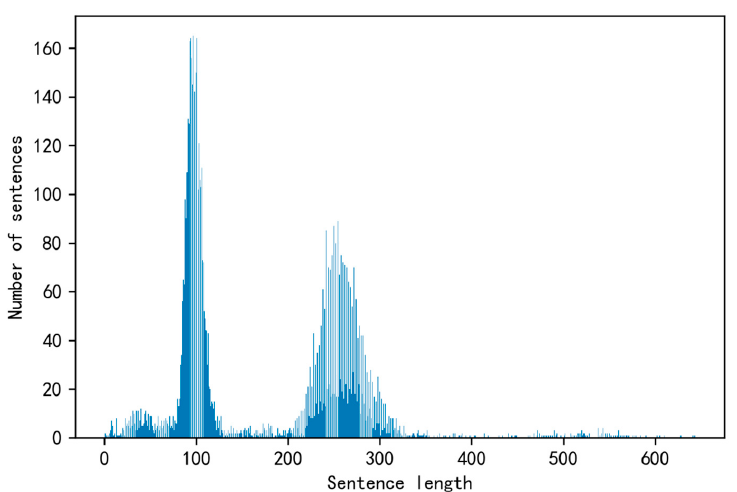
Figure 5. Length of the comment text of the Sydney Opera House in Australia.